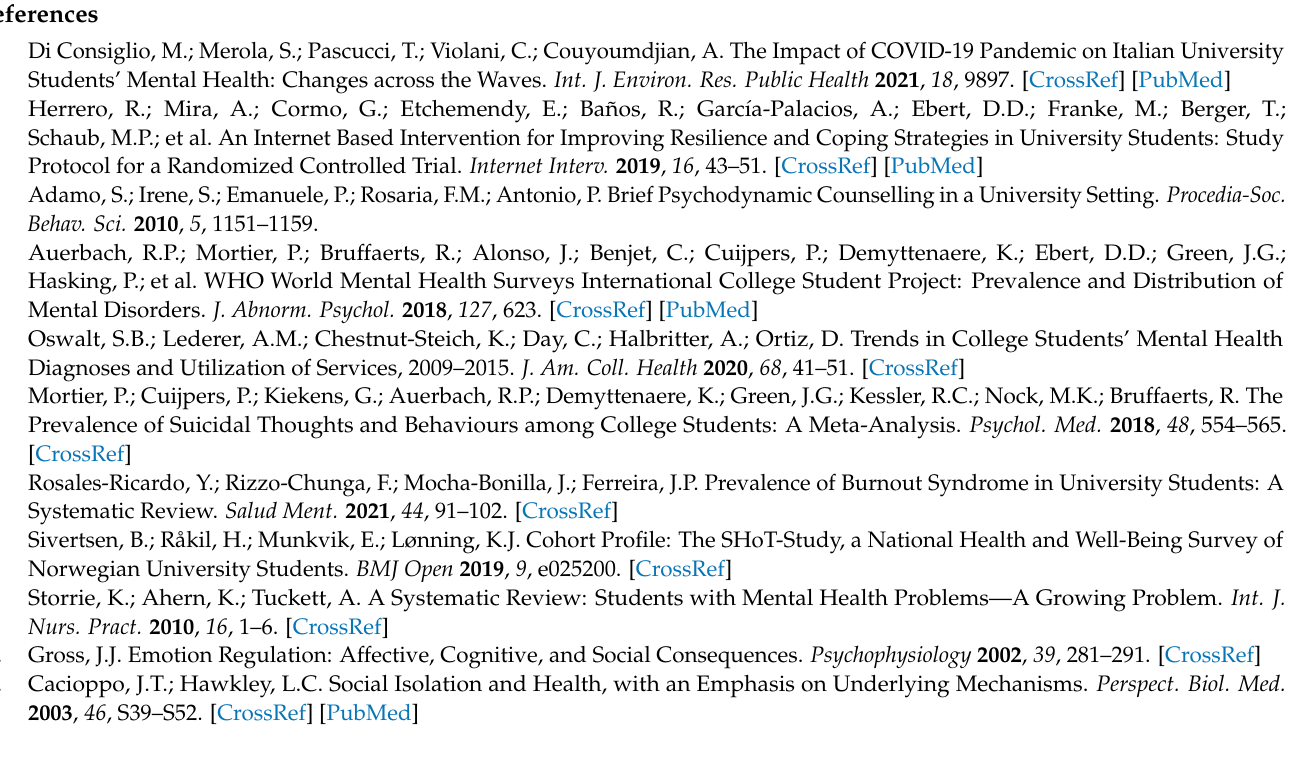
Figure S2: Detailed screening in the two arms of the